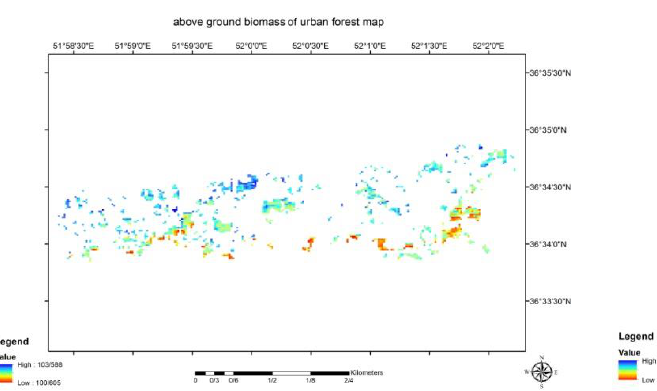
Figure 6. Above ground biomass of urban forest map in 2018 Figure 7. Carbon stock of urban forest in